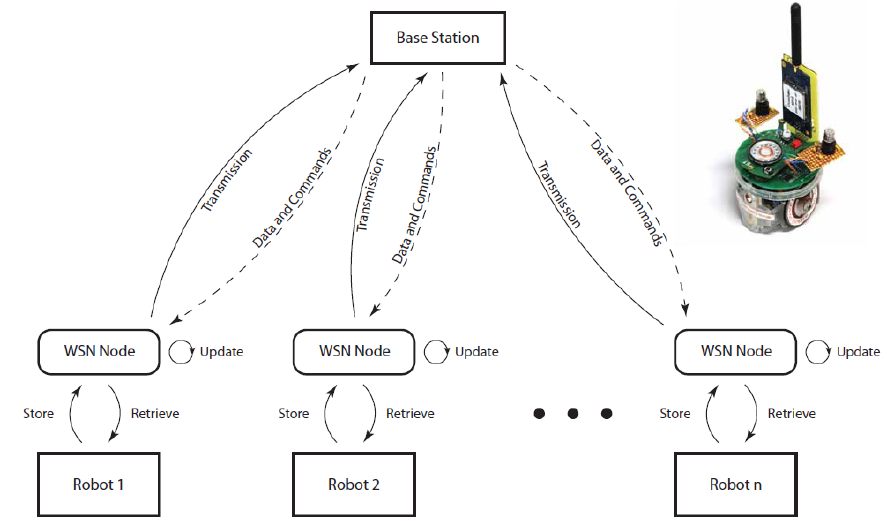
Figure 6. Overview of Robot interactions via WSN and an example of a robot with a WSN transceiver.